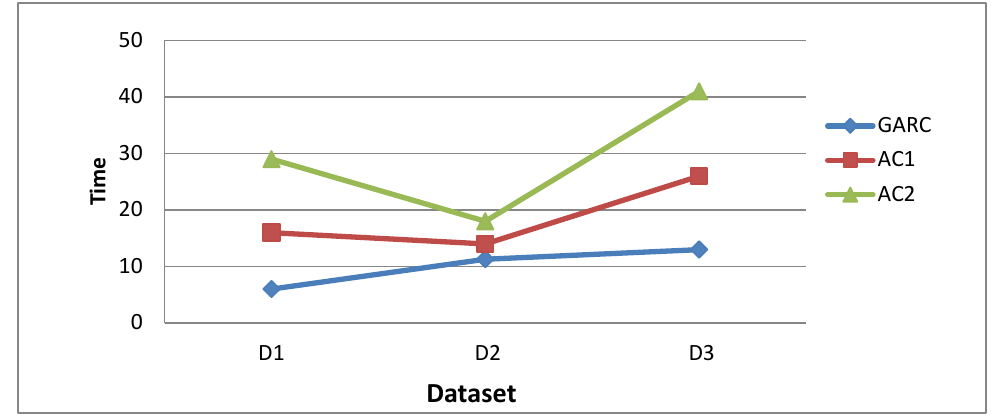
Fig. 4. Comparison of time consumption (minute) for GARC and AC approaches for each